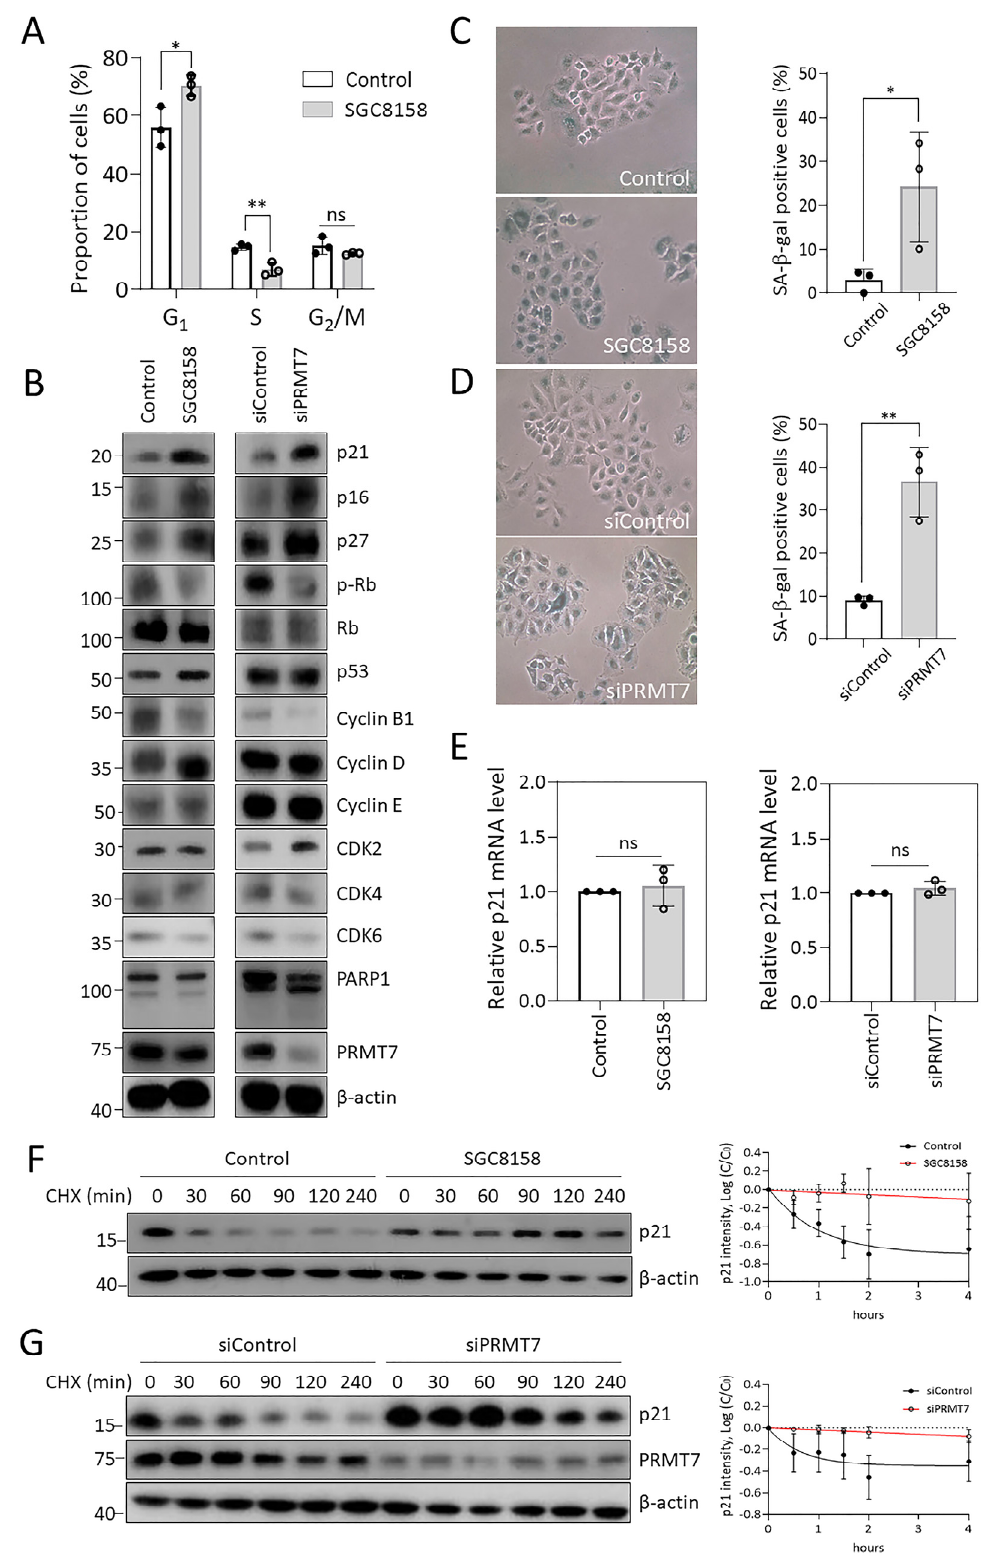
Figure 2. PRMT7 inhibition induces cell cycle arrest and cellular senescence via p21 accumulation. ( A ) After treatment of A549 cells with 10 µ M SGC8158 for 3 days, the proportion of cells in each phase of the cell cycle was measured by FACS analysis. Data are presented as means ± SD of three independent experiments. * p < 0.05 and ** p < 0.01. ( B ) The expression profiles of cell